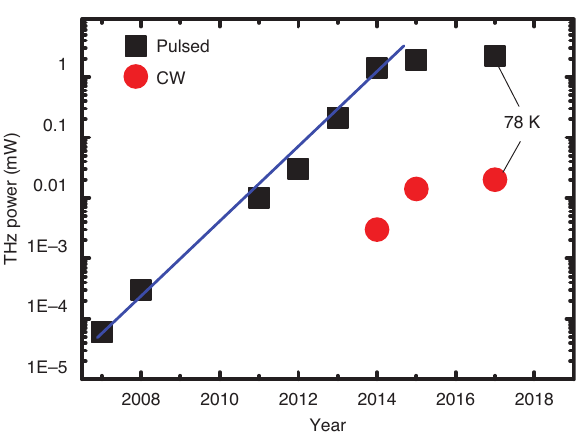
Figure 22: Timeline for the maximum output power in pulsed and CW modes at room temperature obtained by THz DFG-QCLs. The data for 2007 and 2017 are given at cryogenic temperatures, all other data are at room